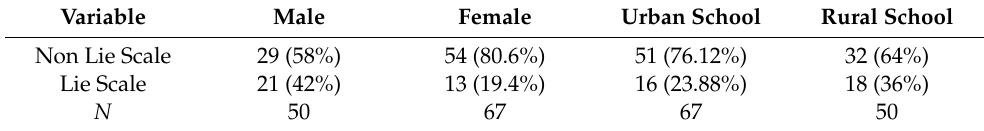
Table 3. Percentage of lie scale group and non lie scale group regarding gender and school type.